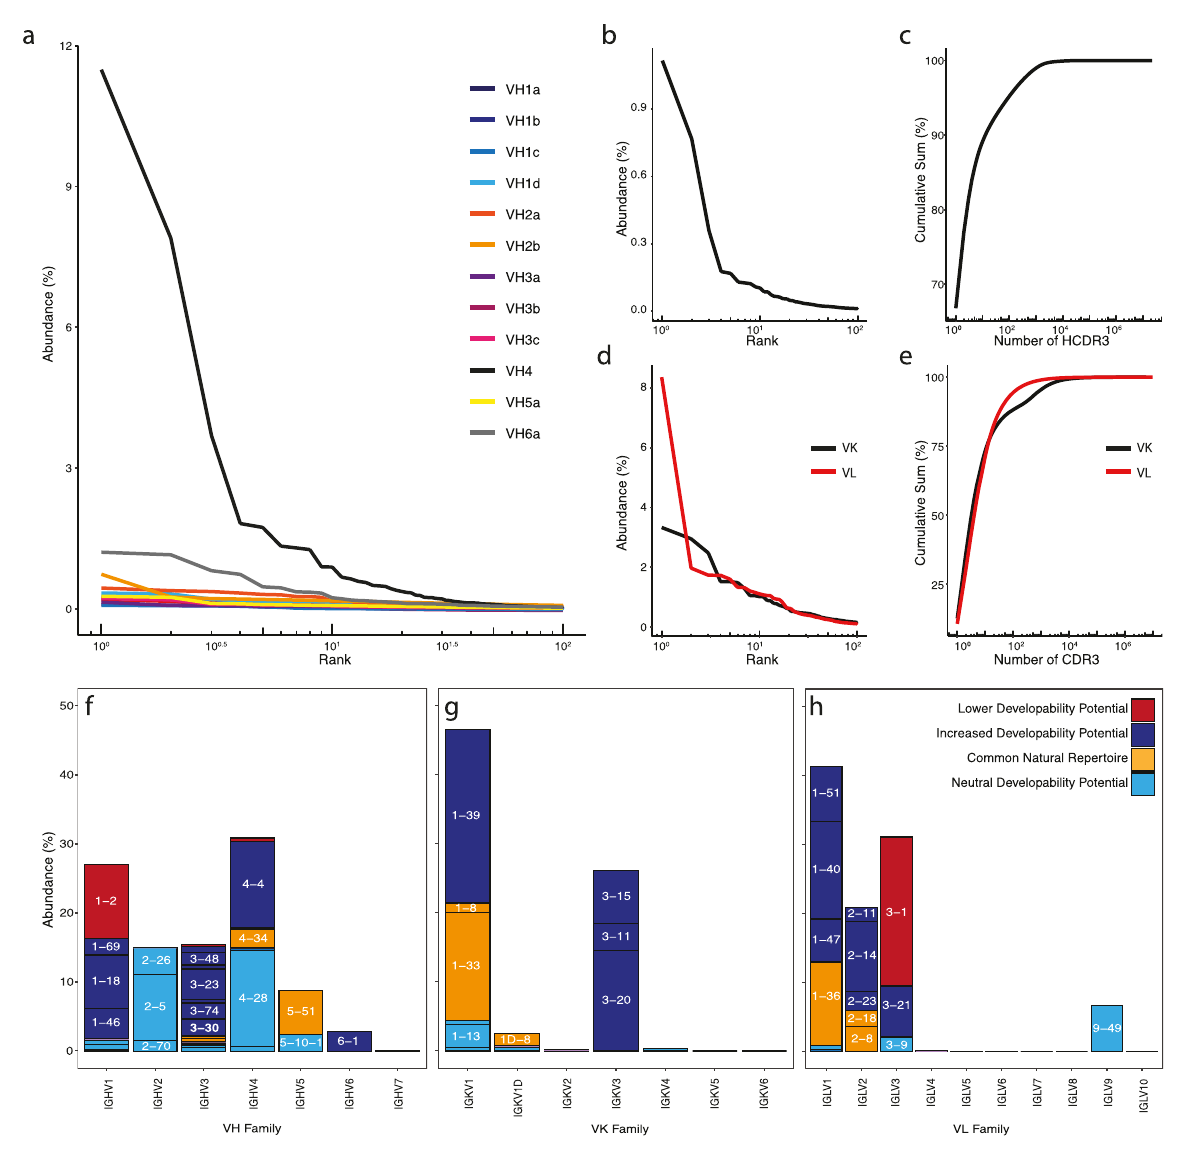
Fig. 4 Primer pair clonal dominance, overlap and relative diversity, and V-region distribution of heavy and light chain in the fi nal library. a Cross-family comparison of clonotype dominance by individual primer sets. b Relative overlap of the HCDR3 among IGHV1 – 5 primer sets. c HCDR3 clonal dominance, d Cumulative clonal rank of HCDR3 assessing % representation by different copies of individual clones (e.g., 1 singletons, 2 duplicates). e LCDR3 cumulative clonal rank of the (IGKV or IGLV) LCDR3. f LCDR3 clonal dominance of the IGKV or IGLV library. Scaffold representation and Tiller ’